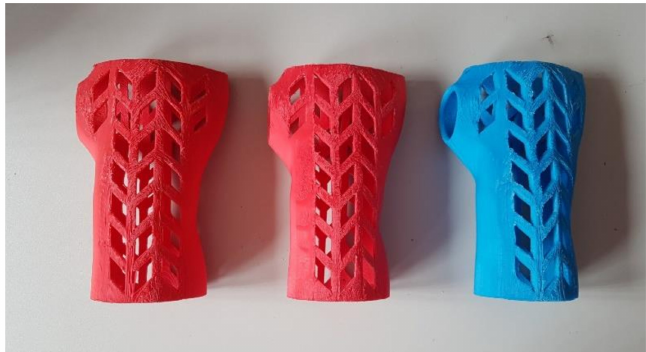
Figure 10. Orthoses manufactured horizontally from ABS, strategies. ( left to right ) Econo, accura, strong.